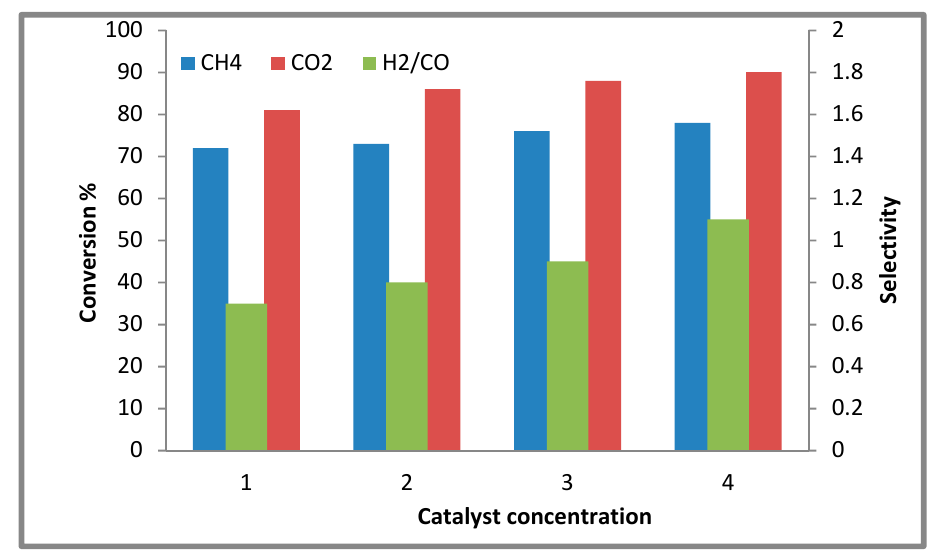
Figure 9. The e ff ect of utilizing ( 1 ) Ni,Pd,Pt / MgO, ( 2 ) Ni,Pd,Pt / Mg 0.97 Ce 4 + 0.03 O ( 3 ) Ni,Pd,Pt / Figure 9. The effect of utilizing ( 1 ) Ni,Pd,Pt/MgO, ( 2 ) Ni,Pd,Pt/Mg 0.97 Ce 4+0.03 O ( 3 ) Mg 0.93 Ce 4 + 0.07 O, and ( 4 ) Ni,Pd,Pt / Mg 0.85 Ce 4 + 0.15 O catalysts on CH 4 , CO 2 conversion, and H 2 / CO ratio Ni,Pd,Pt/Mg 0.93 Ce 4+0.07 O, and ( 4 ) Ni,Pd,Pt/Mg 0.85 Ce 4+0.15 O catalysts on CH 4 , CO 2 conversion, and H 2 /CO at CH 4 :CO 2 ratio of 1:1 ratio and a temperature of 900 ◦ C, with GHSV = 15,000 mL h − 1 g − 1 ratio at CH 4 :CO 2 ratio of 1:1 ratio and a temperature of 900 °C, with GHSV = 15000 mL h − 1 g − 1 cat. Table 4. The DRM reaction results of the catalysts at 900 °C and a CH 4 :CO 2 ratio of 1:1 ratio with GHSV = 15000 mL h − 1 g − 1 cat.